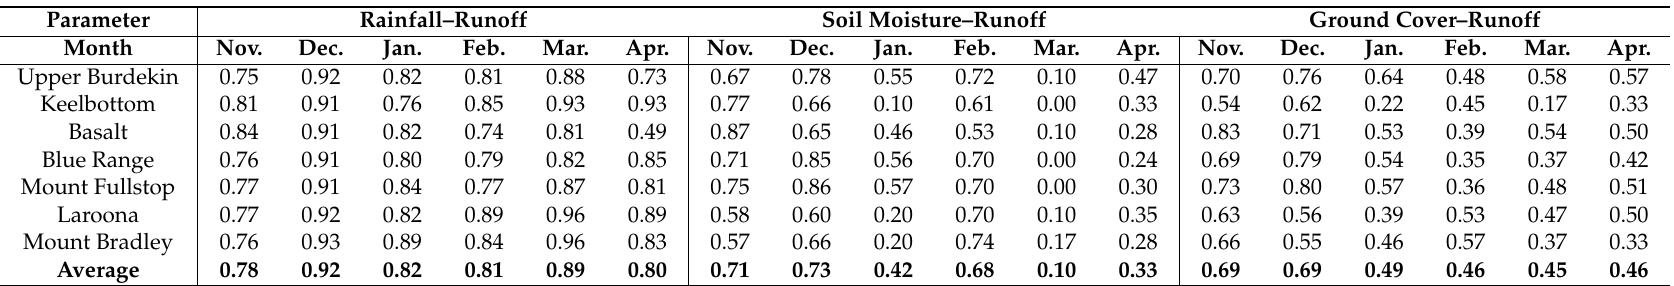
Table 4. Correlation coefficients ( n = 312) between monthly runoff and three parameters: rainfall, antecedent soil moisture and ground cover. Total rainfall of two previous months is used as an indicator of soil moisture. Gainsford and Valley of Lagoons are excluded due to shorter data